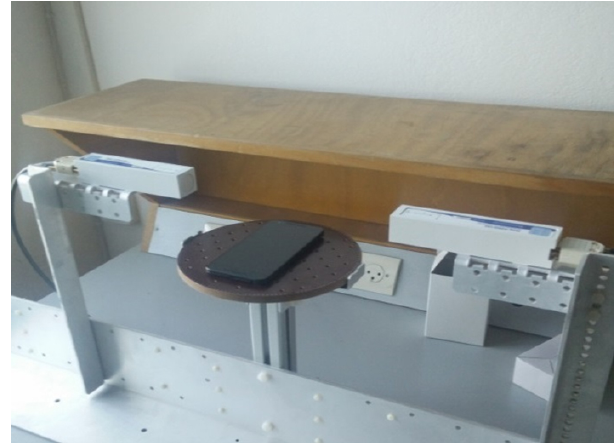
Figure 10. Measuring setup and mobile phone used as EUT.